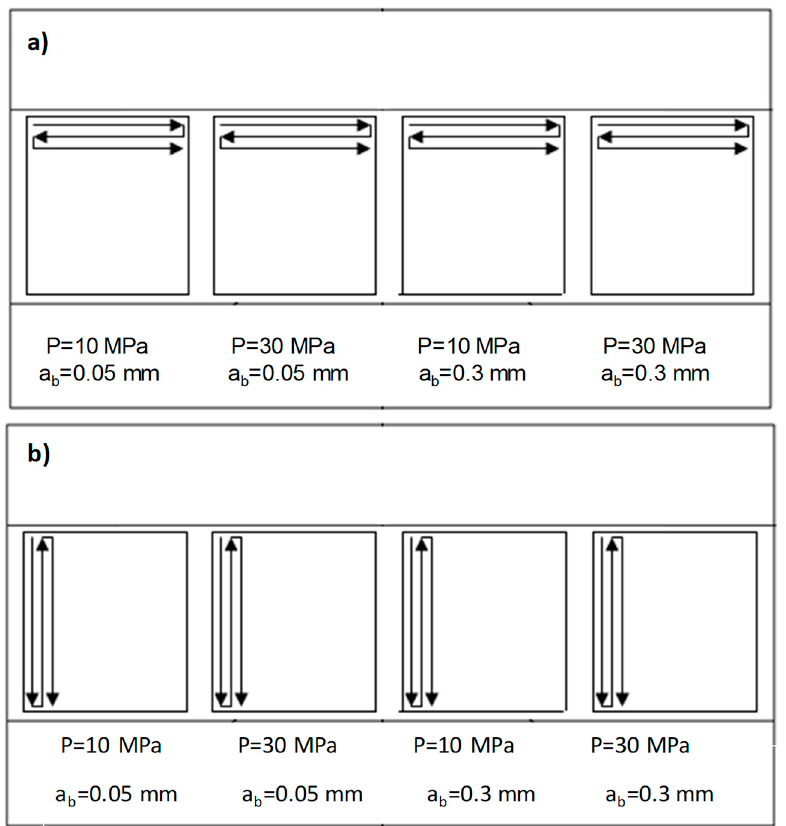
Figure 8. Design of tests in weld plates. ( a ) Burnishing parallel to welding direction. ( b ) Burnishing perpendicular to welding direction.